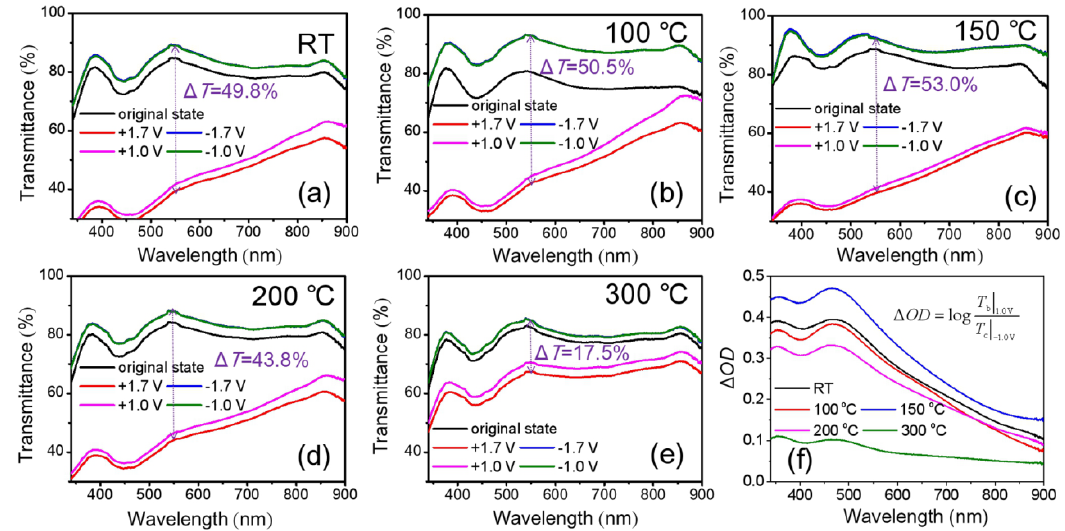
Figure 4. Optical transmittance spectra at as-deposited, colored and bleached states of the NiO x films as a function of annealing temperature: ( a ) RT; ( b ) 100 °C; ( c ) 150 °C; ( d ) 200 °C; ( e ) 300 °C (The increases of voltage has little effect on the T b , so the 2 bleached curves overlap together) and ( f ) Δ OD . The NiO x films are spin-coated three times and the volume ratio in NiO x inks is IPA:DI water = 1:3.